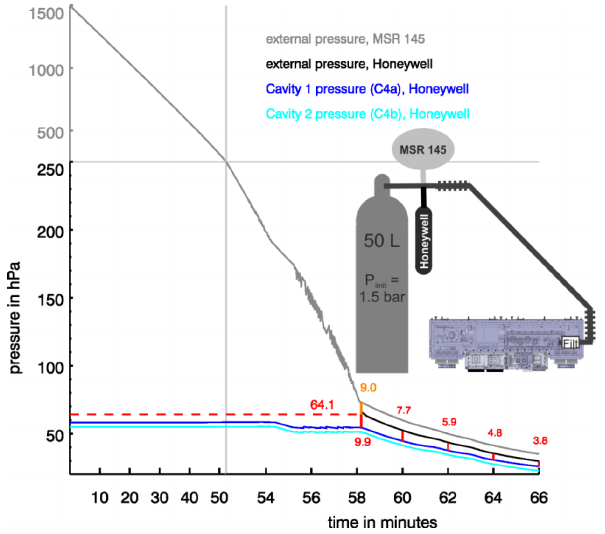
Figure 4. Experimental determination of AMICA cavity pressures (dark blue: cavity 1; light blue: cavity 2) to simulated ambient pres- sure at a 50L gas bottle measured by the pressure gauge of an MSR 145 data logger (grey, absolute range 0–2000hPa, certified accuracy of ± 2 . 5hPa between 750 and 1100hPa) and a Honeywell gauge identical to the gauges C4 inside AMICA (black, range 0–69hPa). At 64.1hPa, the offset between the two gauges is 9.0hPa (shown in orange); at pressures within the range of the Honeywell gauge, we deem this sensor more accurate than the MSR 145 and more comparable to the C4 gauges inside AMICA. For the regime where cavity pressure cannot be regulated, differences between simulated ambient pressure at the 50L bottle and cavity 1 pressure (measured by gauge C4a) are shown in red. Note that the scaling of the x and y axes changes at 52min and 250hPa respectively as shown by the light grey